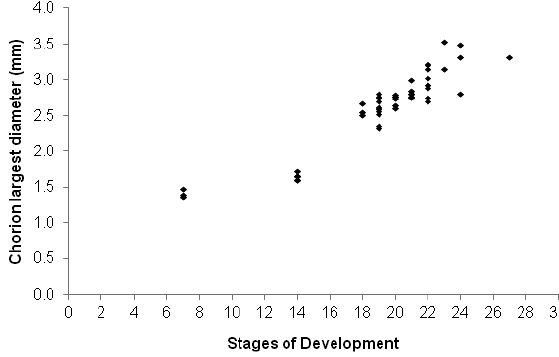
Figure 6 - Increase the size of the chorion of the L. brevis in relation to the stages of egg